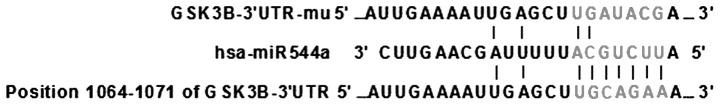
miR-544a can combine with the 3′UTR of GSK3β. miR, microRNA; 3′UTR, 3′ untranslated region.